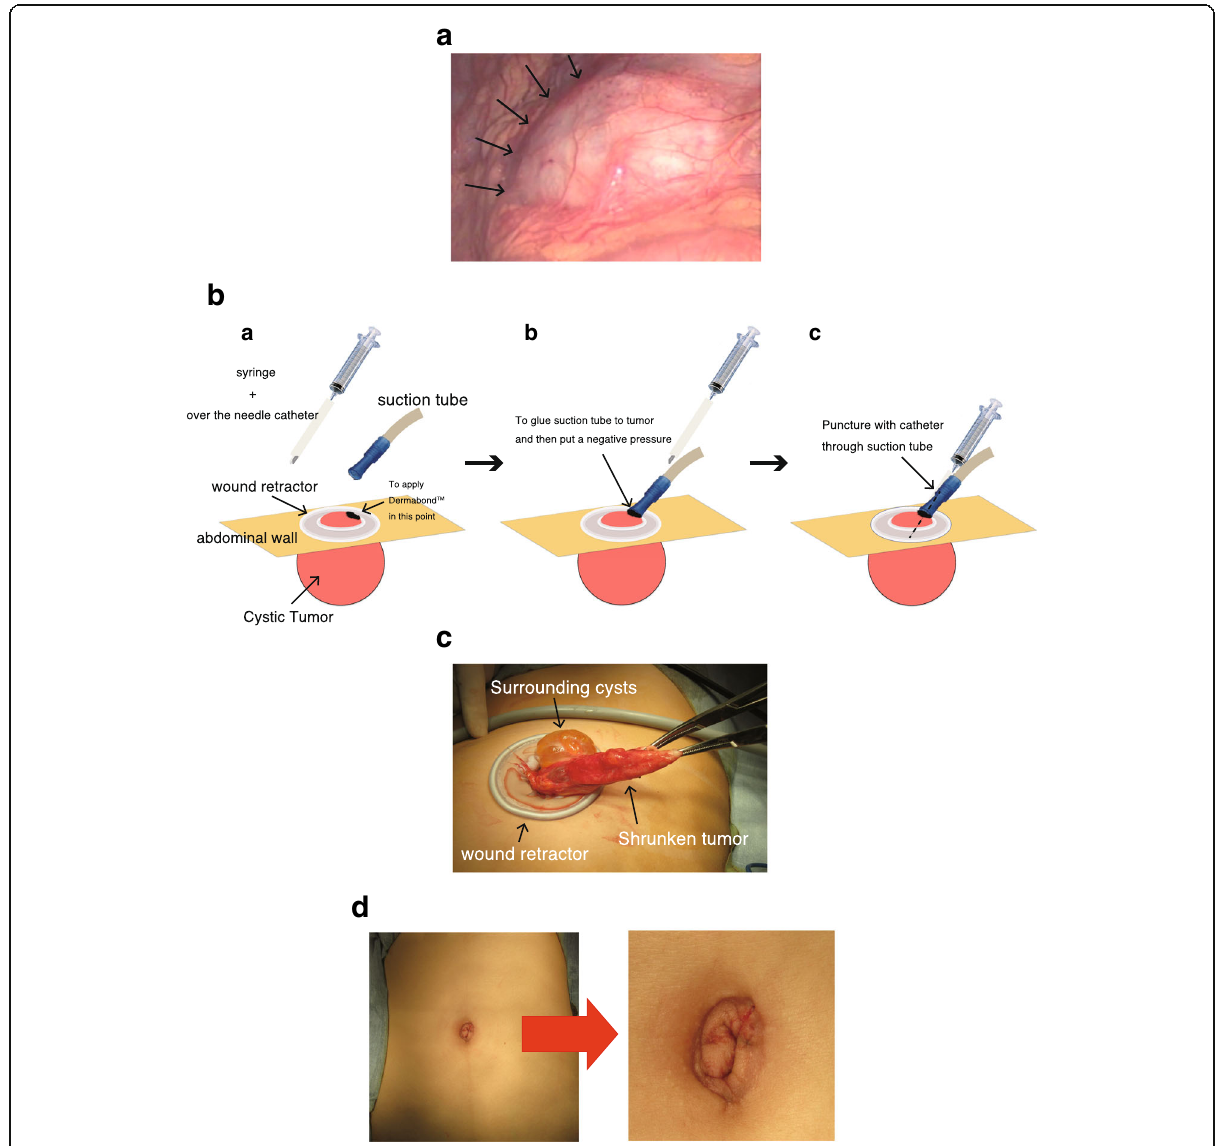
Fig. 2 Surgical photographs. a A large cyst derived from the greater omentum, detected during laparoscopic surgery (arrows). b Schematic illustration of the operative procedure (a – c). The cystic tumor was punctured using a 16-gage over-the-needle catheter via a plastic suction tube, and the fluid was aspirated from the cyst. The glue and suction tube with negative pressure prevented spillage of any cyst fluid into the abdominal cavity. c Retraction of the large cyst after the aspiration of the cyst fluid. d The postoperative wound. The operation was successfully completed with only a small